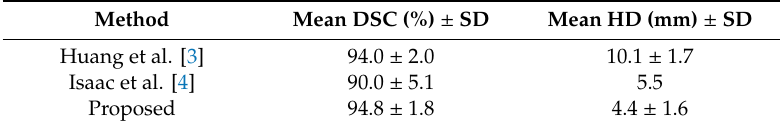
Table 2. CT image segmentation quality of the proposed method and state-of-the-art.